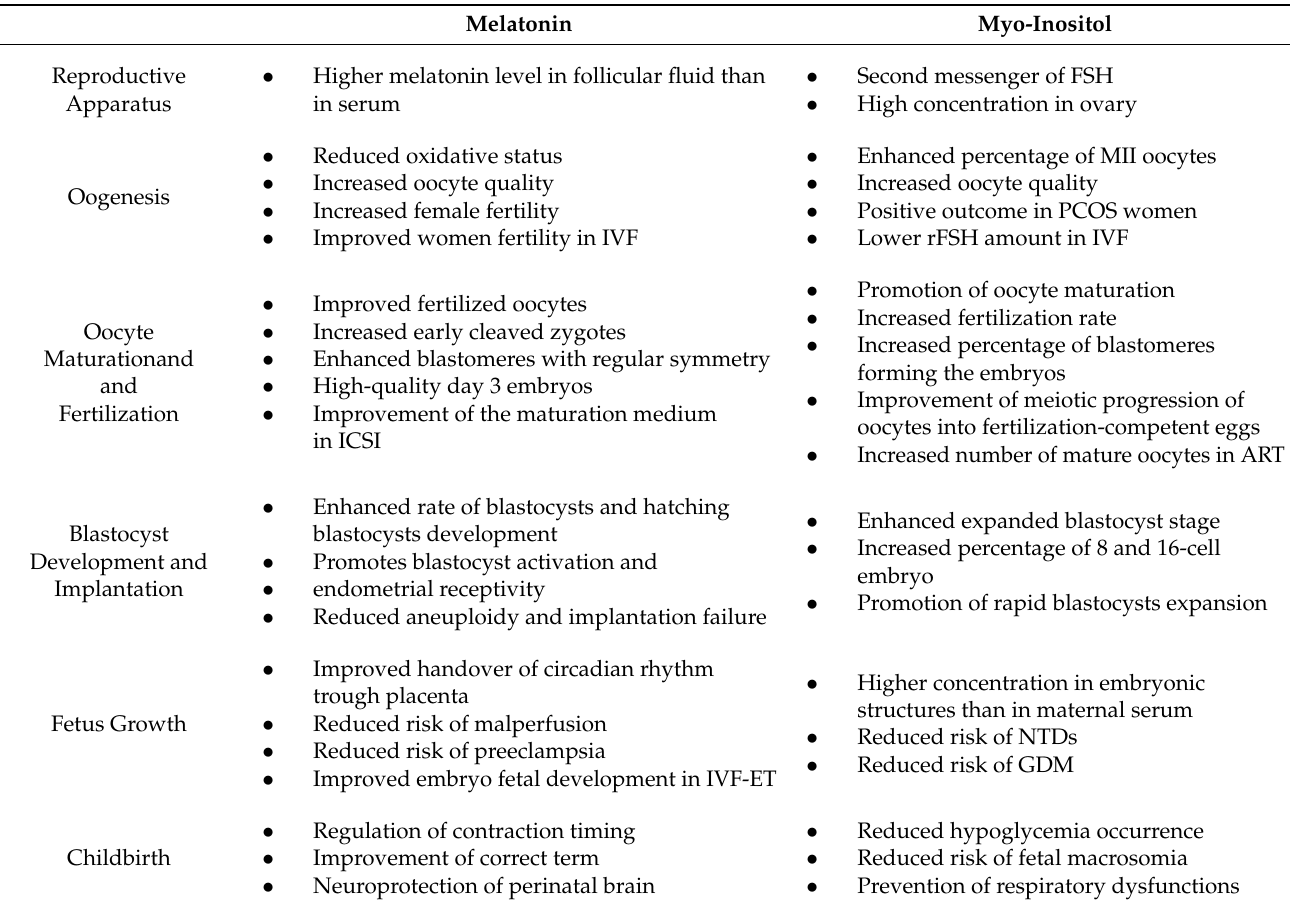
Table 1. Summary of melatonin and myo-ins activity during pregnancy. Melatonin